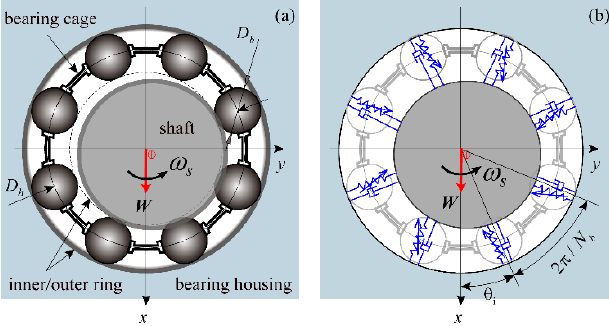
Figure 1. Schematic diagram of ( a ) the ball bearing system, and ( b ) its two degrees-of-freedom spring model.